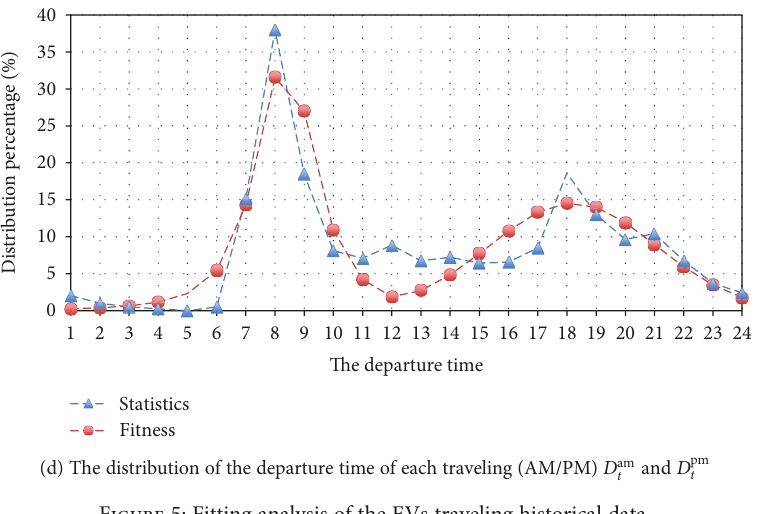
Figure 5: Fitting analysis of the EVs traveling historical data. Table 2: Description of the charging strategies.